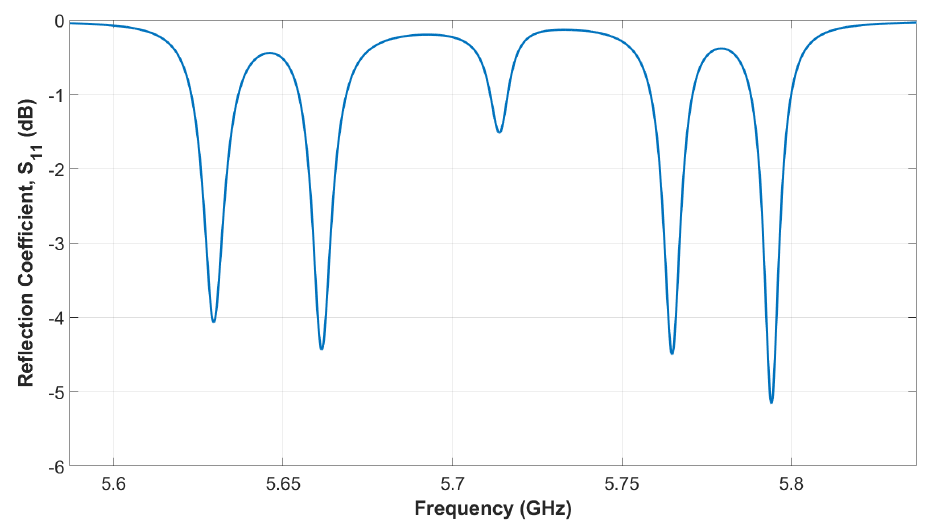
Figure 5. The reflection coefficient S11 in decibels (dB), simulated using CST Studio Suite code in Frequency Domain Solver.